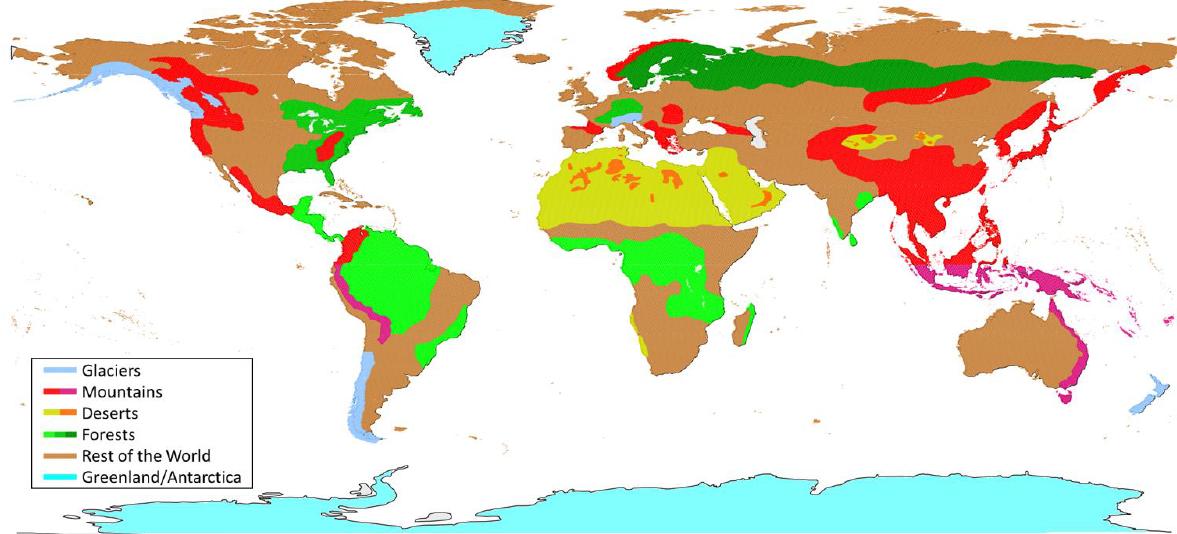
Figure 2. Acquisition areas for the TanDEM-X Change